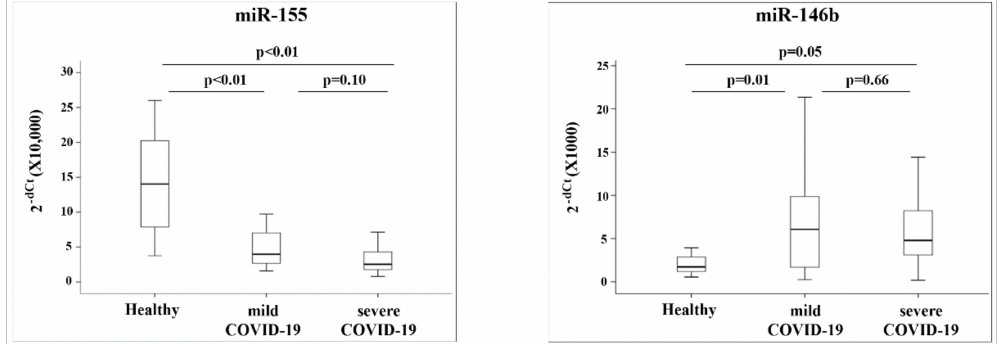
Figure 2. MiRNA expression in healthy, mild and severe COVID-19